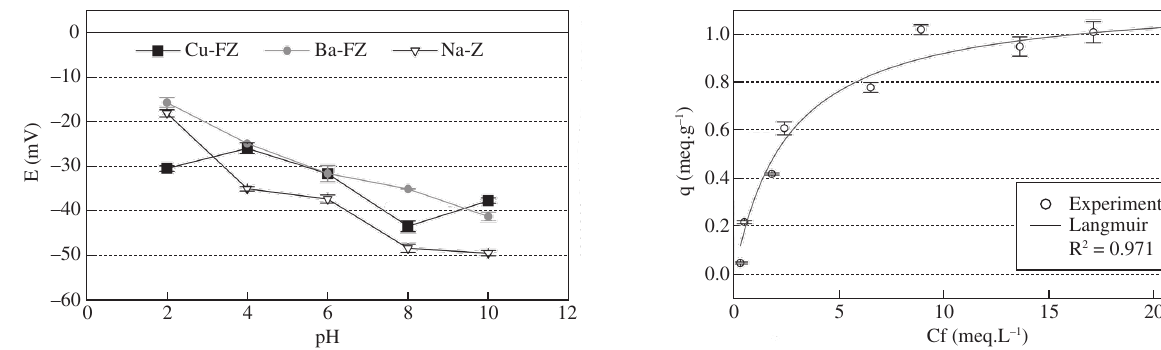
Figure 10. Equilibrium data (isotherm) of sulphate ions uptake, from aque- ous solutions, by flocculated modified zeolites. Contact time: 2 hours, Ba-Z: 10 g.L –1 , temperature: 25 °C, pH: